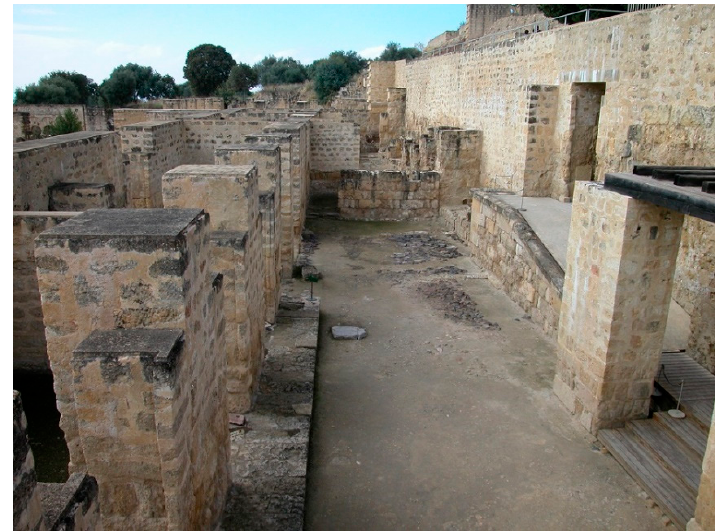
Figure 17. Trapezoidal Space: Buildings Nos. 10 and 9 (© Conjunto Arqueológico de Madinat al-Zahra).